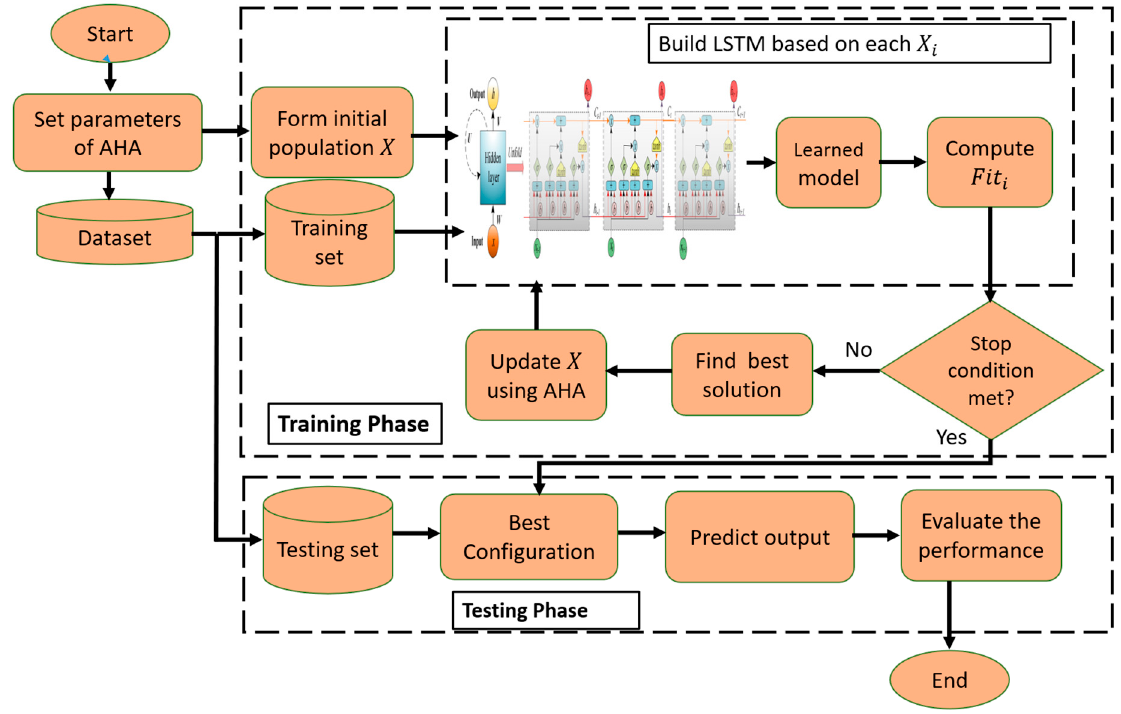
Figure 2. Structure of LSTM-DMO model.